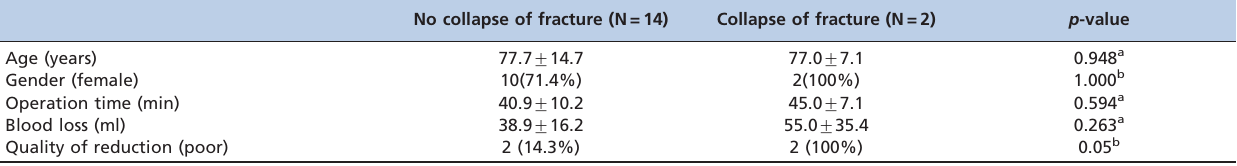
Table 3 - Factors that may be predictive of a ‘‘collapse of fracture’’ result.